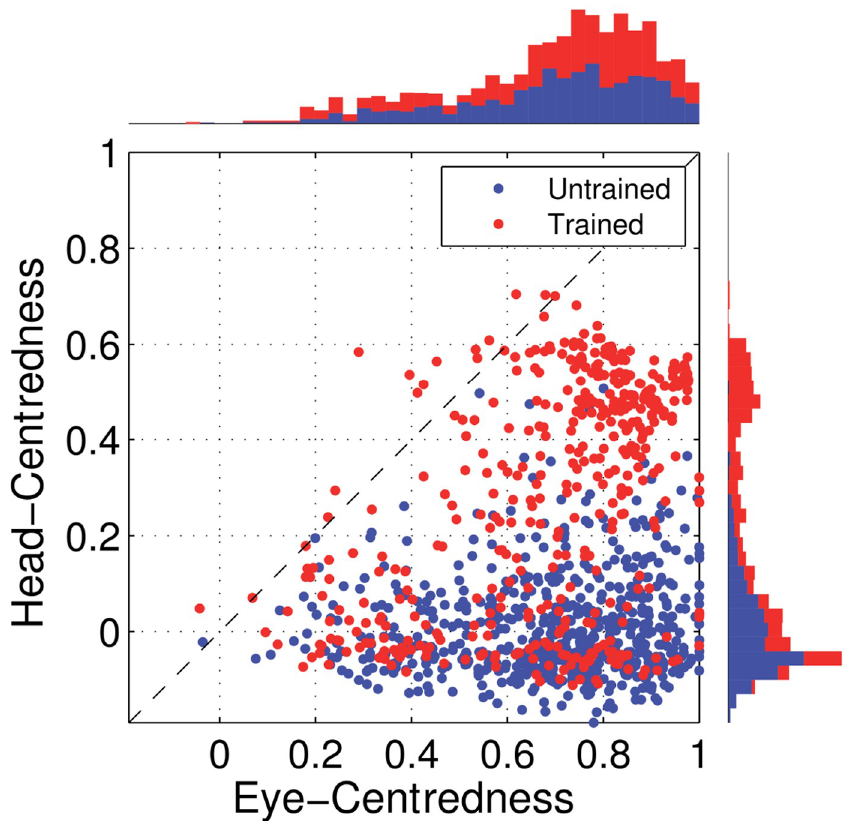
Fig 17. Simulation results showing the output reference frame response characteristics of a model incorporating a population of sigmoidal modulated input neurons trained with the modified learning rule 18: Delayed postsynaptic firing rate with anti-Hebbian learning. The scatter plot shows the reference frame response characteristics of all output neurons before and after training. Conventions as for Fig 14. It is evident that training had the effect of increasing the head-centredness values of most output neurons. Indeed many more head-centred output neurons are present in the trained model than in the untrained model.